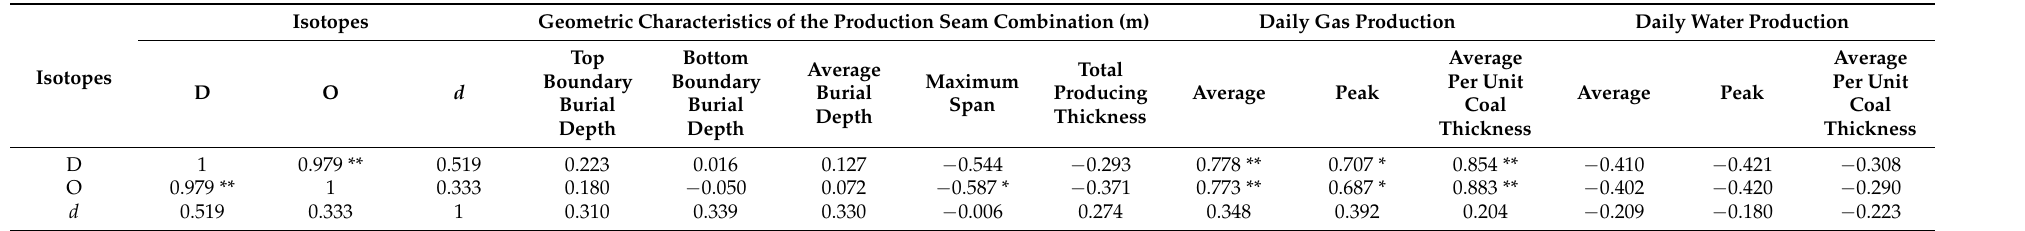
Table 3. Correlation coefficients between the stable isotopic compositions of the produced water and the production